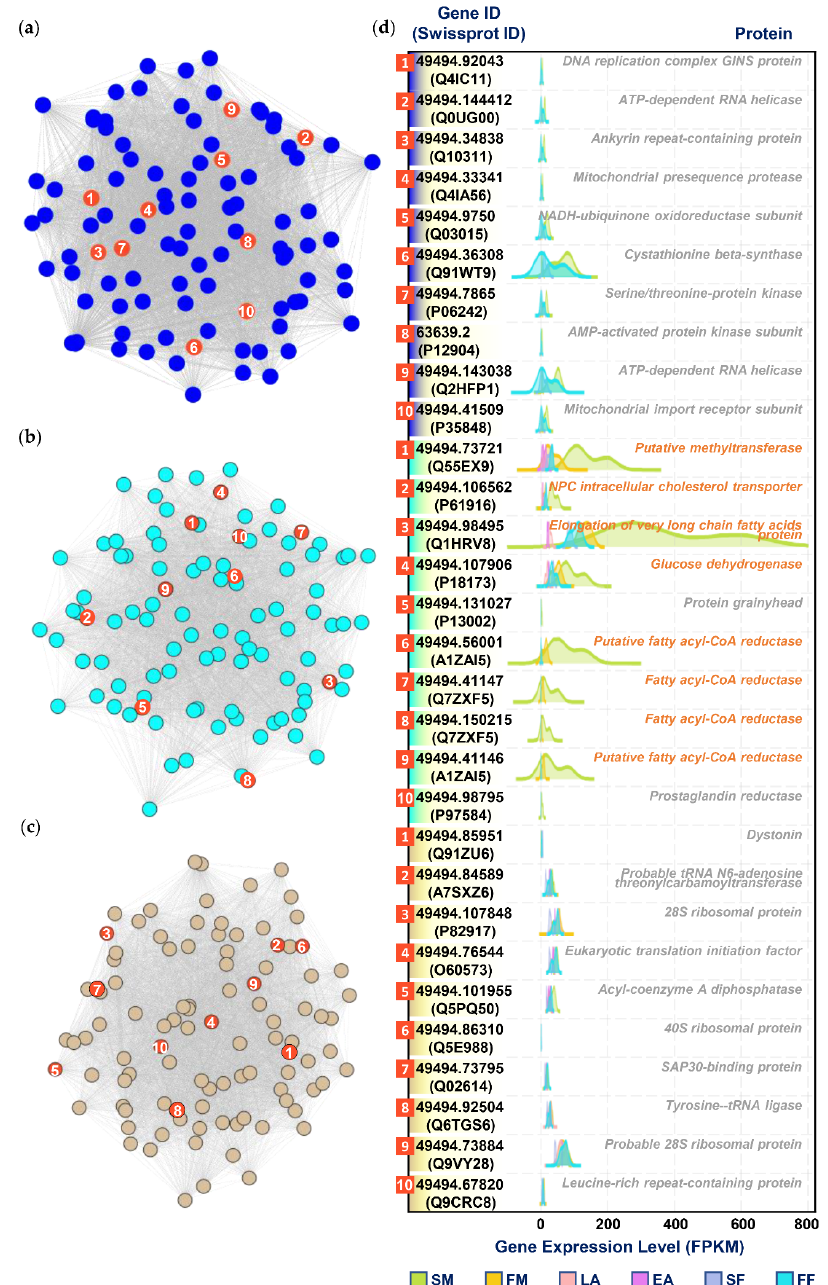
Figure 4. The screened hub genes related to wax secretion are displayed through a visual network structure diagram and ridgeline plots. ( a – c ) represent the visualization of the network connections between the top 100 genes with the most connections in the blue ( a ), cyan ( b ), and tan ( c ) modules, which were generated by the Cytoscape software. The nodes marked in red are the top 10 nodes (genes) with the largest degree calculated by the CytoNAC plugin, and the 1 to 10 numbers marked in the nodes are the order of the degree of the nodes in descending order. ( d ) Ridgeline plots of the expression levels of the selected hub genes in each sample. FM , SM , FF , SF , EA, and LA in the figure, respectively, represent first-instar male, second-instar male, first-instar female, second-instar female, early female adult, and late female adult. On the left side of the panel is the ID corresponding to the gene in the sequencing result, the annotated Swissprot ID is in brackets, and the text on the right side of the panel corresponds to the annotated protein function. The genes marked with orange are the genes whose expression levels in SM are significantly higher than those of the other